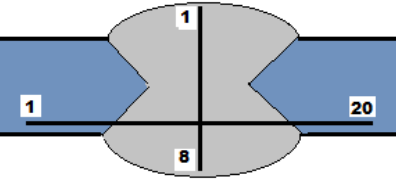
Figure 5. Schematic illustration of microhardness measurement areas.